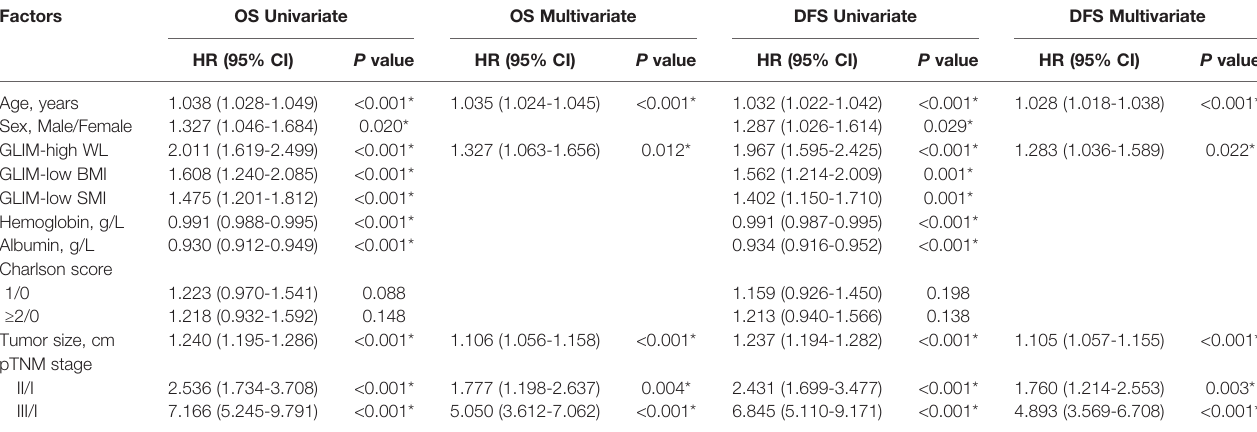
TABLE 4 | Univariate and multivariate Cox regression analysis for OS and DFS in the entire cohort.